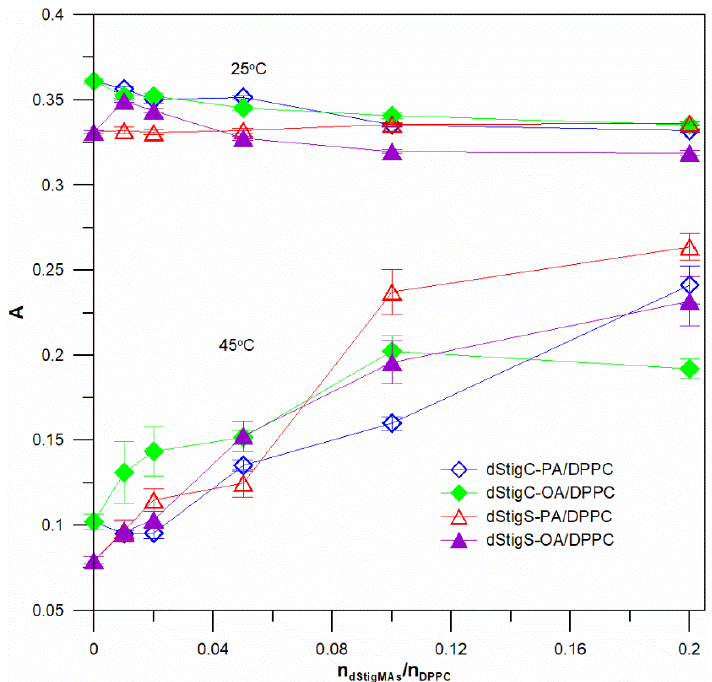
Figure 4. Values of fluorescence anisotropy of the DPH probe for different concentrations of the tested compound in the lipid membrane. Measurements made at two temperatures 25 and 45 °C for SUVs formed from DPPC and dStigMAs.